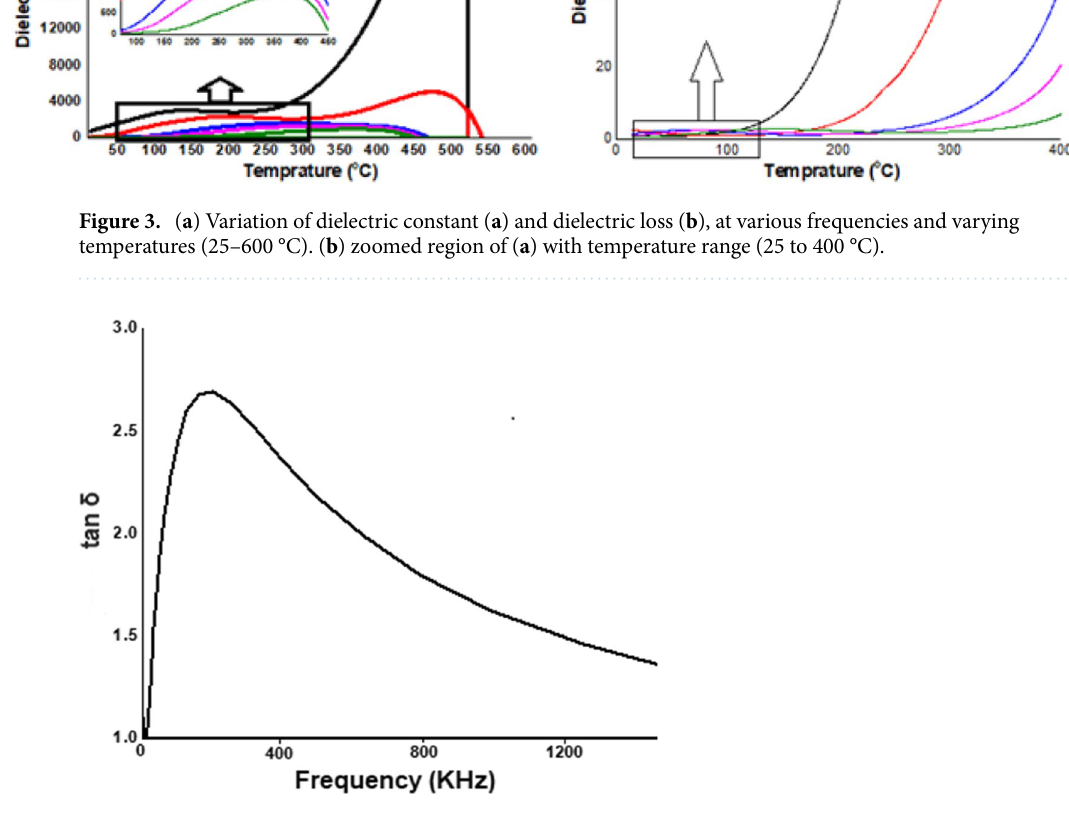
Figure 4. The change of tangent δ with change in frequency at room temperature (25